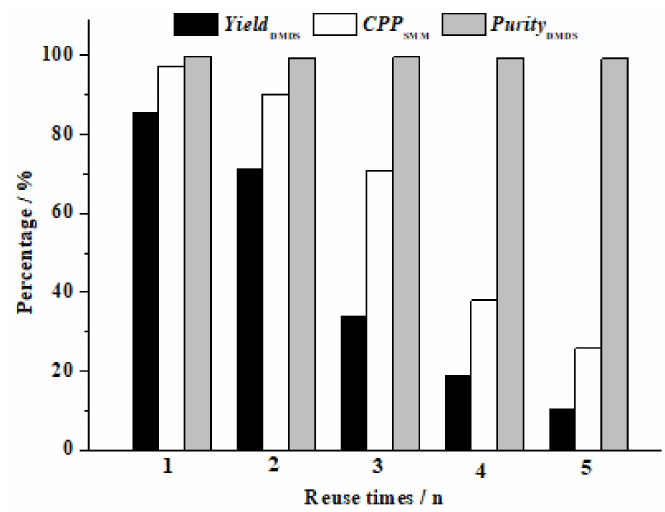
Figure 12. The effect of reuse times of commercial AC-CoPcS catalyst on CPP SMM , Yield DMDS , and Purity DMDS. Experimental conditions: SMM (18.0 wt%) 450 g, RR = 600 r/min, C ca = 1333.3 ppm,